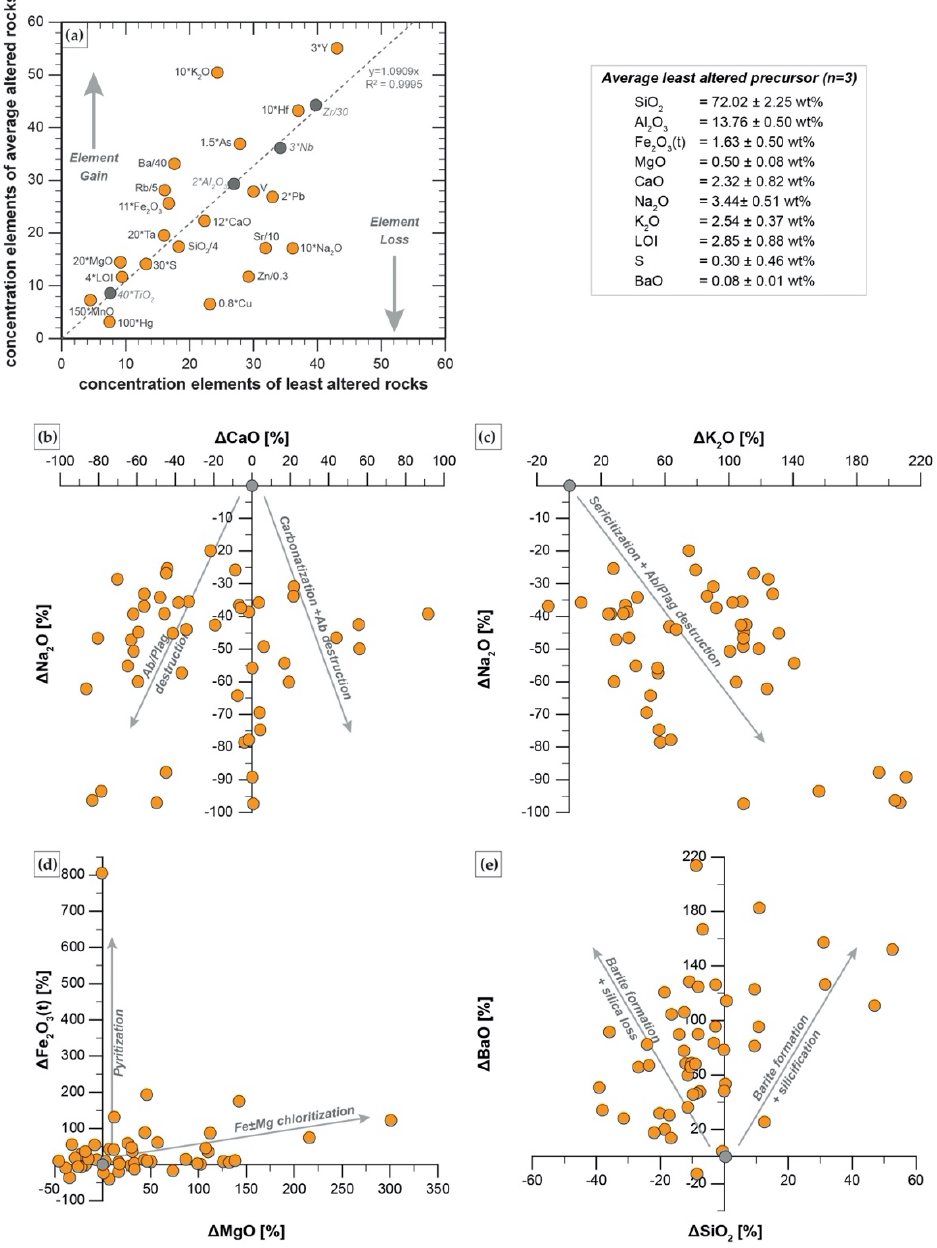
Figure 24. Mass balance calculation for altered felsic units from the A6 Anomaly. ( a ) Isocon diagram using the method of Grant [100,101] showing element gains and losses (orange circles) relative to immobile elements Al 2 O 3 , TiO 2 , Nb, and Zr (dark grey circles) that describe the isocon (dashed line). Altered rocks underwent relative volume loss since isocon has a slope of > 1. All elements are subjectively scaled using the method described by Mukherjee and Gupta [114] to better visualize gain/loss of elements, ( b – e ) Mass balance changes of altered felsic flows (orange circles) relative to an average of least altered sample (grey circle at point of origin) using the calculations of MacLean [103] and MacLean and Barrett [104]. All changes are given in %, ( b ) Δ CaO vs. Δ Na 2 O displaying feldspar destruction and carbonatization, ( c ) Δ K 2 O vs. Δ Na 2 O displaying strong K gain due to sericitization at expense of albite and plagioclase destruction, ( d ) Δ MgO vs. Δ Fe 2 O 3 (t) displaying Fe and Mg gain due to Fe-Mg-chloritization and pyritization (Fe gain), ( e ) Δ SiO 2 vs. Δ BaO displaying silica gain or loss with formation of barite. Composition of average precursor (n = 3) with standard deviation is given in upper right for selected elements. See text for details. Abbreviations: Ab—albite, LOI—loss on ignition, Plag—plagioclase.